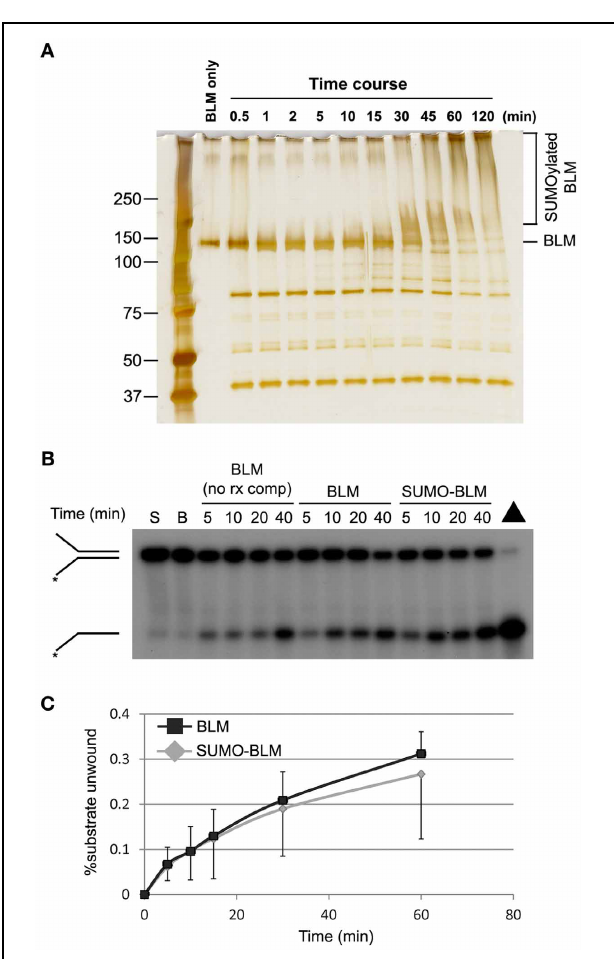
FIGURE 4 | DNA helicase activity of SUMOylated BLM is similar to unSUMOylated BLM. (A) BLM SUMOylation reactions were carried out, time points were removed, and the reactions were stopped with sample buffer. The reaction products were analyzed by sodium dodecyl sulphate-polyacrylamide gel electrophoresis followed by silver staining. (B) SUMOylated (SUMO-BLM) or unSUMOylated BLM (BLM) was prepared by incubating 200ng of purified recombinant BLM with SUMO reaction components in the presence (to make SUMOylated BLM) or absence (to make unSUMOylated BLM) of ATP. Helicase assays were performed by incubating the SUMO reaction products with 32 P-labeled synthetic replication-fork substrate, and the helicase reactions were stopped at different times. The products were analyzed by non-denaturing polyacrylamide gel electrophoresis followed by autoradiography. The position of the forked duplex and the unwound product are indicated on the left. S, unreacted substrate; B, beads only with unreacted substrate; (cid:2) , boiled substrate; BLM (no rx comp), helicase reactions performed with BLM protein that was not exposed to SUMO reaction components as a positive control. (C) Graph showing quantification of the percentage of unwound substrate by SUMOylated and unSUMOylated BLM prepared in these experiments by nickel-NTA pull down. A minimum of two DNA unwinding experiments were performed for each method of BLM SUMOylation preparation shown in (B) and (C)